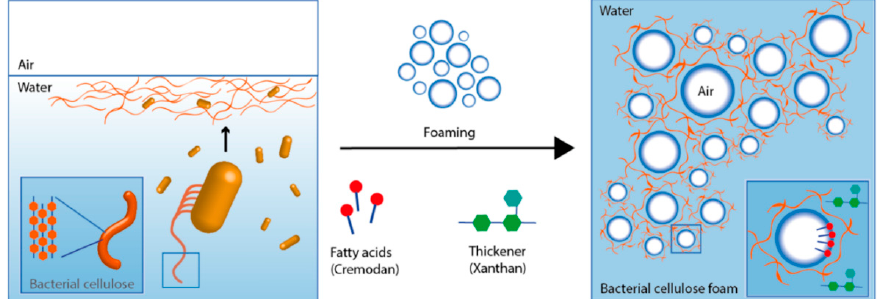
Figure 16. Schematic of the bacterial cellulose foam formation process. G. xylinus extrudes bacterial cellulose as a function of oxygen and migrates toward the air–water interface. To construct a bacterial cellulose foam, a suspension of G. xylinus in growth media is foamed. © Nature, 2018 [254]. Insects also contain unique nanostructures implicated in specific physical and physiological functions (Figure 17). Adhesion, chemical sensing, and response, color vision and manipulation, movement, mechano-sensation, and thermoregulation are the mentioned functions [255,256]. For instance, in fairyflies, wings have very thin hairs (300 nm–2.5 µ m in diameter) that allow them to move freely at different speeds because hair spacing influences the force produced by moving. The insects wing membranes are flexible, but they are characterized by the flexural stiffness required to withstand the air mass. The wing thickness is hugely heterogeneous amongst insect’s species. For instance, it is <500 nm in fruit flies ( Drosophila species) and >1 mm in the strong forewings of beetles (order Coleoptera) [257]. In insects, the stunning visual display is the results of the light interaction with nanostructures and is the perfect example of the nanostructure role in color vision and color manipulation (i.e., structural coloration) [256]. Photonic structures comprise at least two materials with different refractive indexes (RI) and mesoscale periodicity (i.e., 200 nm) for constructive interference of visible light [256]. In insects, these photonic structures are frequently formed by dielectric materials with low light absorption [e.g., cuticles (RI = 1.55), air (RI = 1), and pigmented layers, such as melanin layers] to obtain the appropriate RI contrast. Moreover, fireflies use bioluminescence to lure mates or for prey hunting during the night [258]. They emit a yellow to pale red light (520 to 670 nm) due to the presence of nanostructures in their body [256].